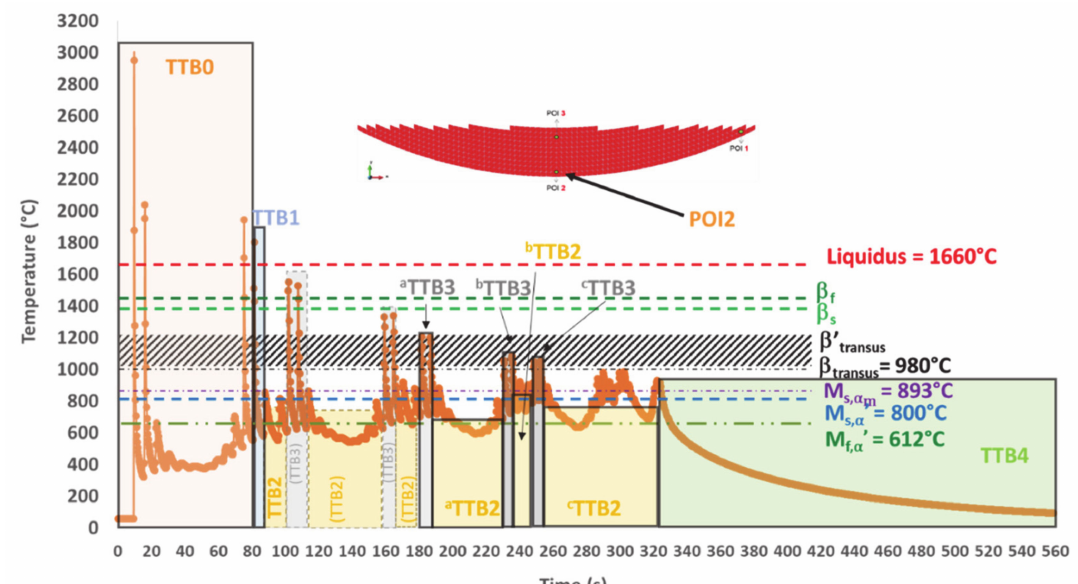
(cid:12) (cid:12) . (cid:12) (cid:12) T (cid:12) is lower than the CCR of 20 (cid:12)